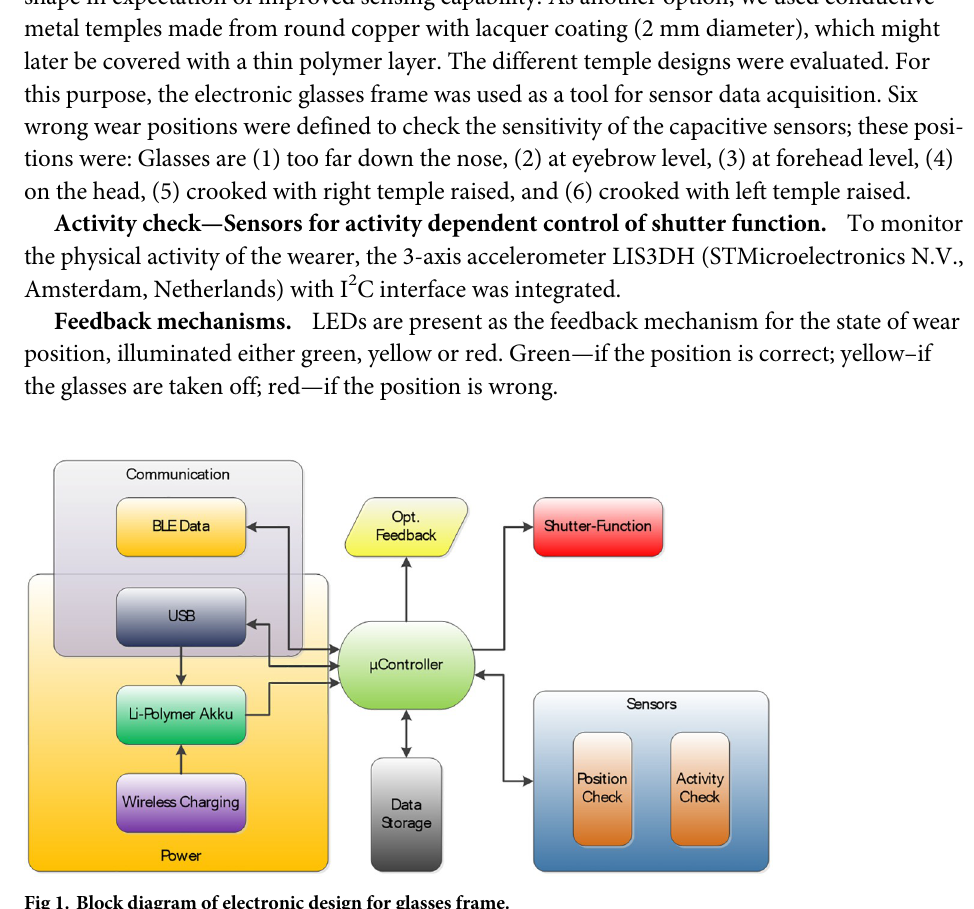
Fig 1. Block diagram of electronic design for glasses